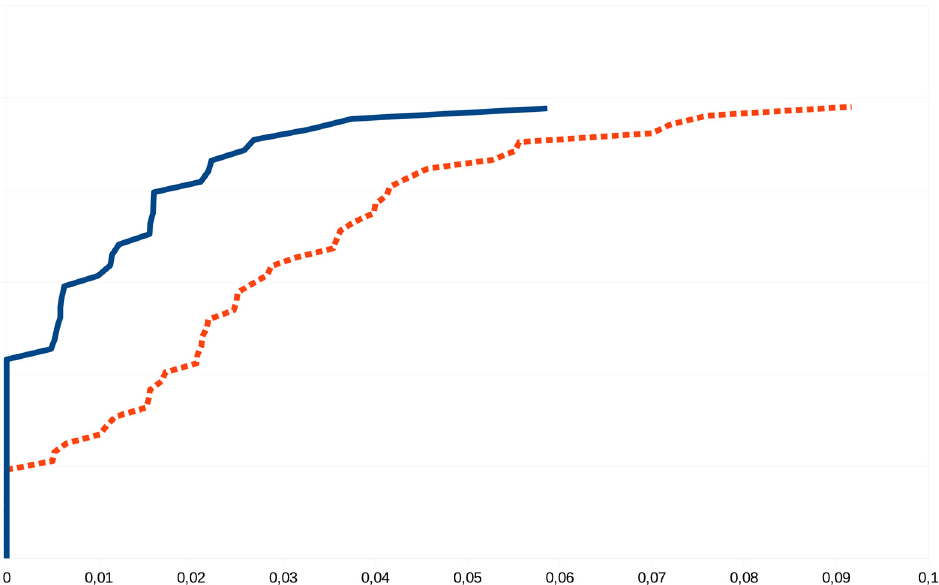
Fig 3. Empirical cumulative distribution function of the Right_MinCutBalDivSum_FAMean graph parameter (that is, edge-number-normed minimum bisection width in the right hemisphere, weighted by the arithmetic mean of the fractional anisotropies [35] of the fibers, belonging to the edge) in the 129-node resolution. For every value x on the horizontal line, the curves demonstrate the male (blue, continuous line) and female (red, dashed line) fraction of subjects with Right_MinCutBalDivSum_FAMean value of at most x . For example, for x = 0.02, 40% of the females have the Right_MinCutBalDivSum_FAMean value less than x , while about 85% of males have that value less than x .